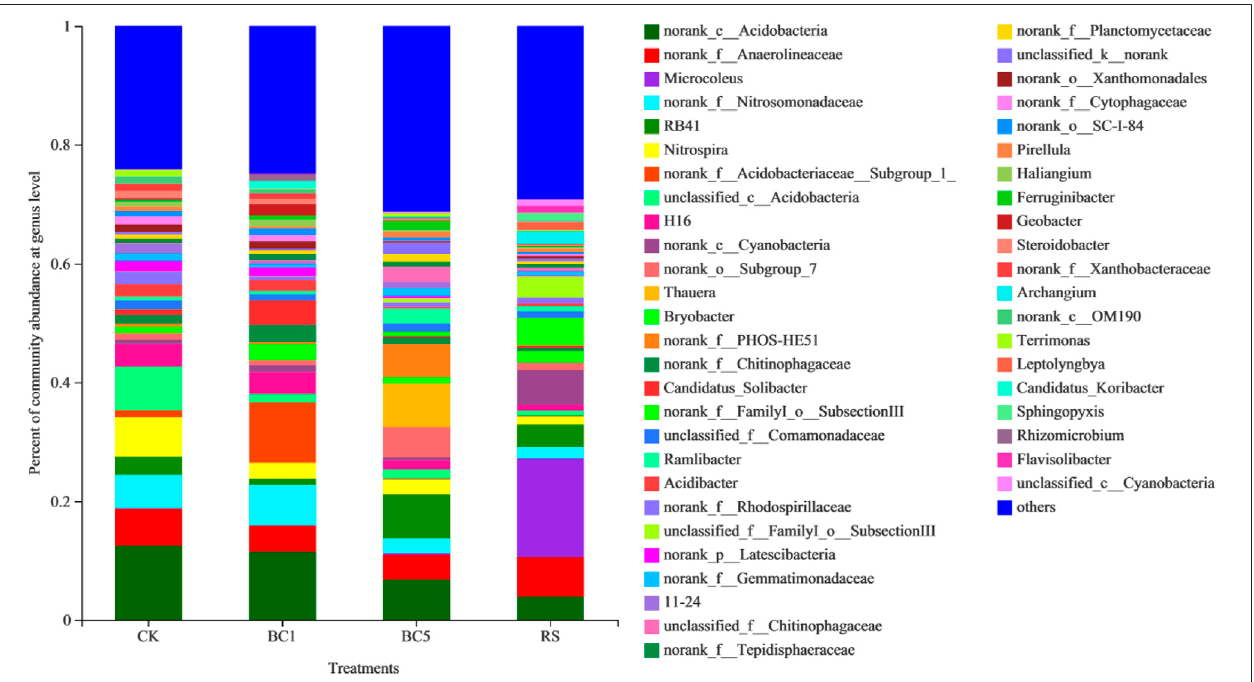
FIGURE5| Relativeabundanceofdominantgeneraasaffectedbythelong-termsuccessivebiocharandricestrawamendment.CK:withoutbiocharorricestraw; BC1: 2.25 Mgha − 1 biochar; BC5: 11.25 Mgha − 1 biochar; RS: 2.25 Mgha − 1 rice straw.